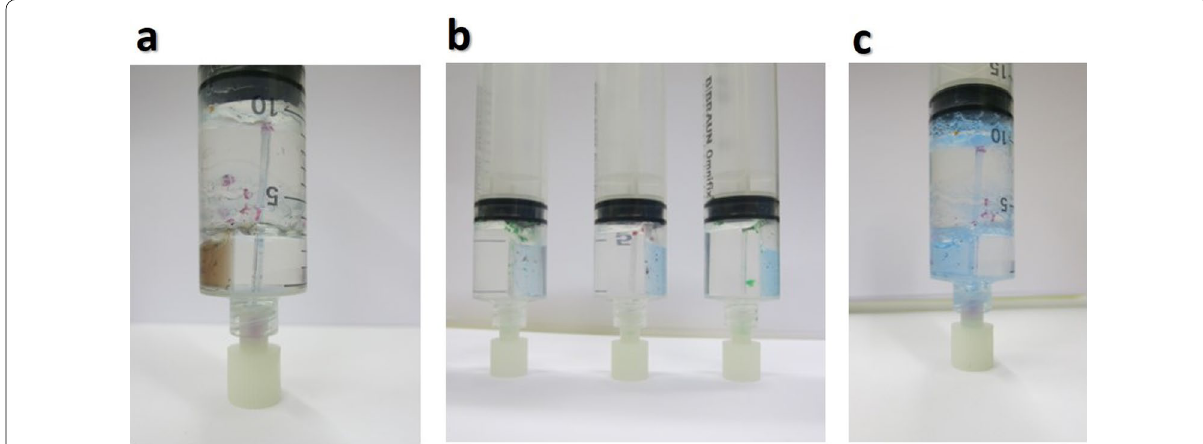
Fig. 3 PDMS-assisted lab-in-a-syringe device for determination of total protein content. a Filled with the Bradford reagent; b after the reaction with BSA at the single PDMS curing device; c After the reaction with BSA at the two-step PDMS curing